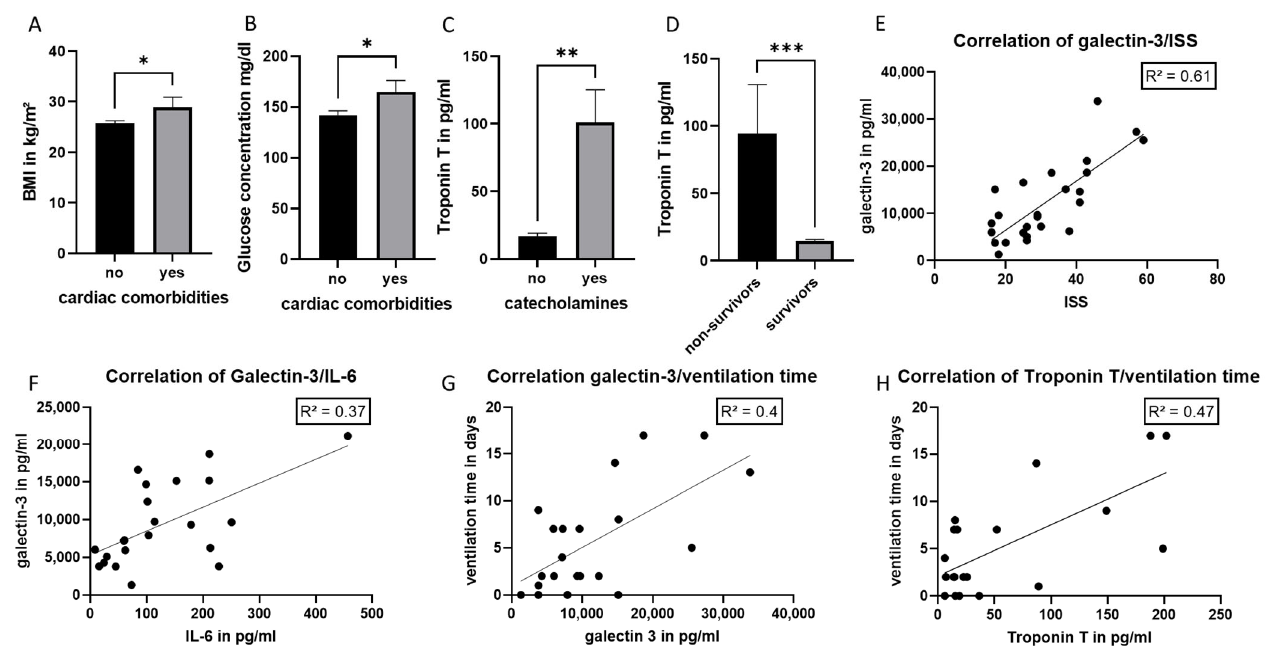
Figure 5. Patients with cardiac comorbidities–subgroup analysis. Body Mass Index (BMI) ( A ) and initial blood glucose concentration ( B ) in patients with (yes) and without (no) cardiac comorbidities. ( C ) Troponin T concentration in the subgroup of patients with cardiac comorbidities depending on the need of catecholamines. ( D ) Patients with cardiac comorbidities: Troponin T concentration in survivors and non ‐ survivors. ( E ) Correlation analysis between galectin ‐ 3 and the Injury Severity Score (ISS). Correlation analysis between galectin ‐ 3 and IL ‐ 6 ( F ) or the ventilation time ( G ). ( H ) Correlation analysis between troponin T concentration and the ventilation time. n = 24 patients, * p ≤ 0.05; ** p ≤ 0.01; *** p ≤ 0.001.